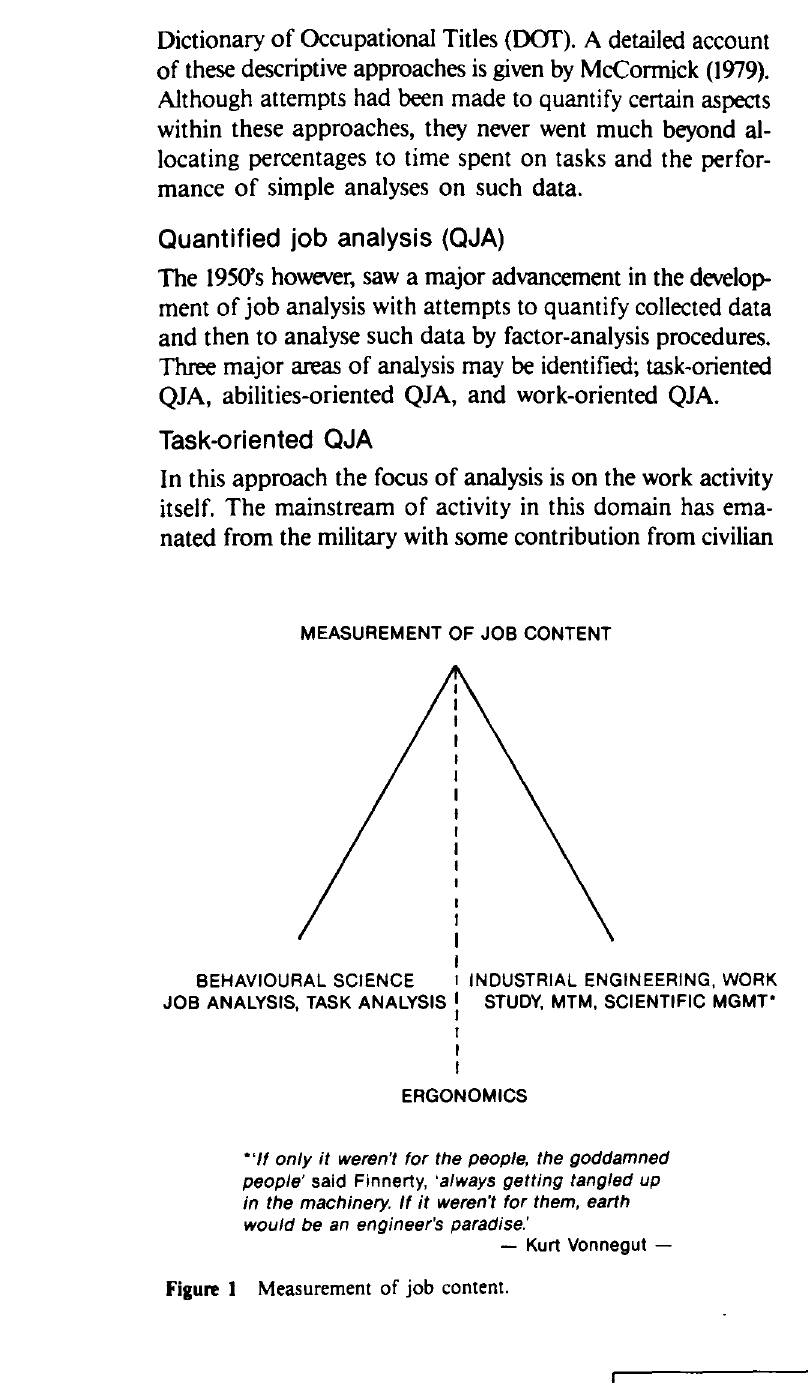
Figure 1 Measurement of job content.